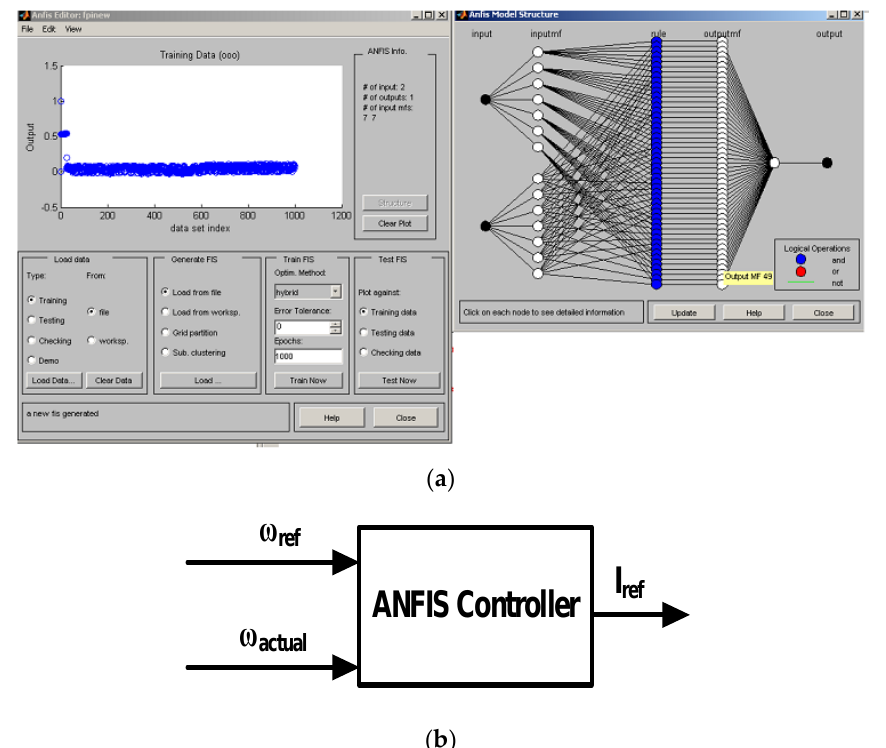
Figure 4. Simulation view of ANFIS controller. ( a ) Structure of ANFIS controller with its membership function. ( b ) ANFIS logic.